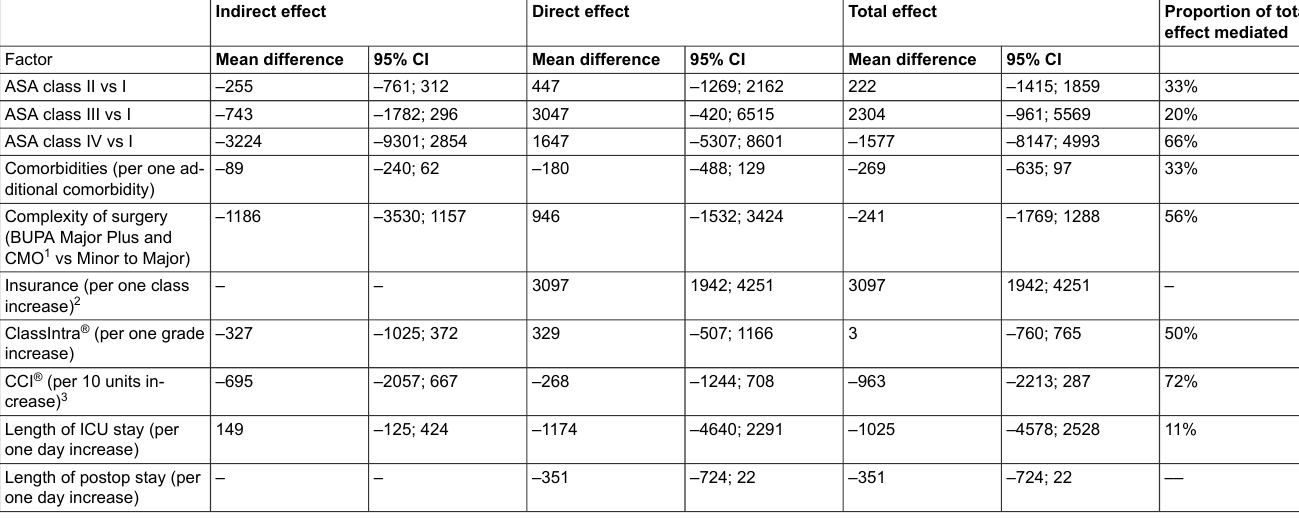
Table 4: Indirect, direct and total effects on reimbursement (in